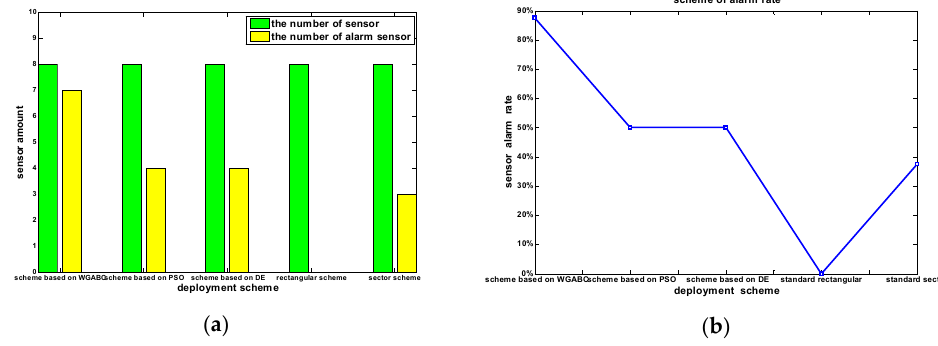
Figure 6. ( a ) The number of alarm sensors in different deployment schemes; ( b ) The alarm rate curves in different deployment schemes.